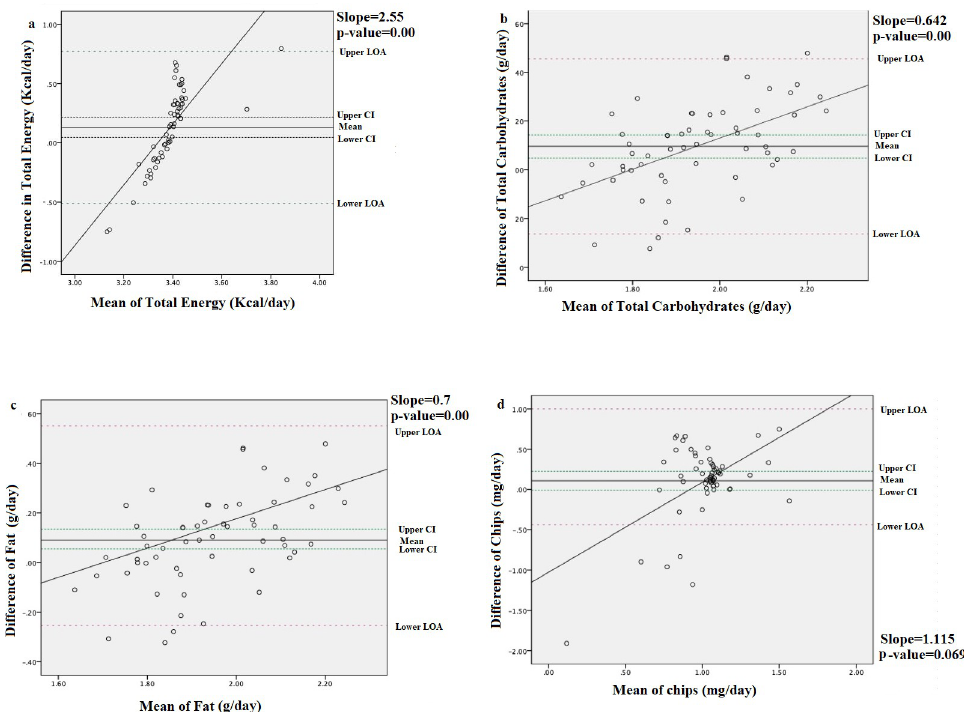
Fig 2. Bland–Altman plots for energy intake, selected energy-adjusted nutrient and food group intakes showing the varying levels of agreement obtained between mean (ln) and differences in intakes measured by the AE-FFQ and the three 24HRs: (a) energy intake (Kcal/day); (b) total carbohydrate, (c) total fat(g/day); (d) chips 24HR = 24-hour dietary recall; AE-FFQ = Adult Emirati food frequency questionnaire; ln = natural log.